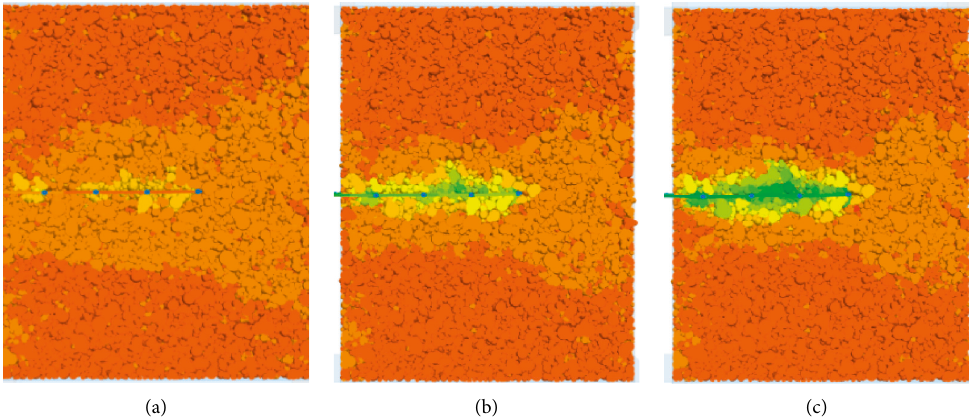
Figure 7: Evolution of the influencing zone under a vertical load of 50kPa. (a) 5mm, (b) 10mm, and (c) 15 mm.